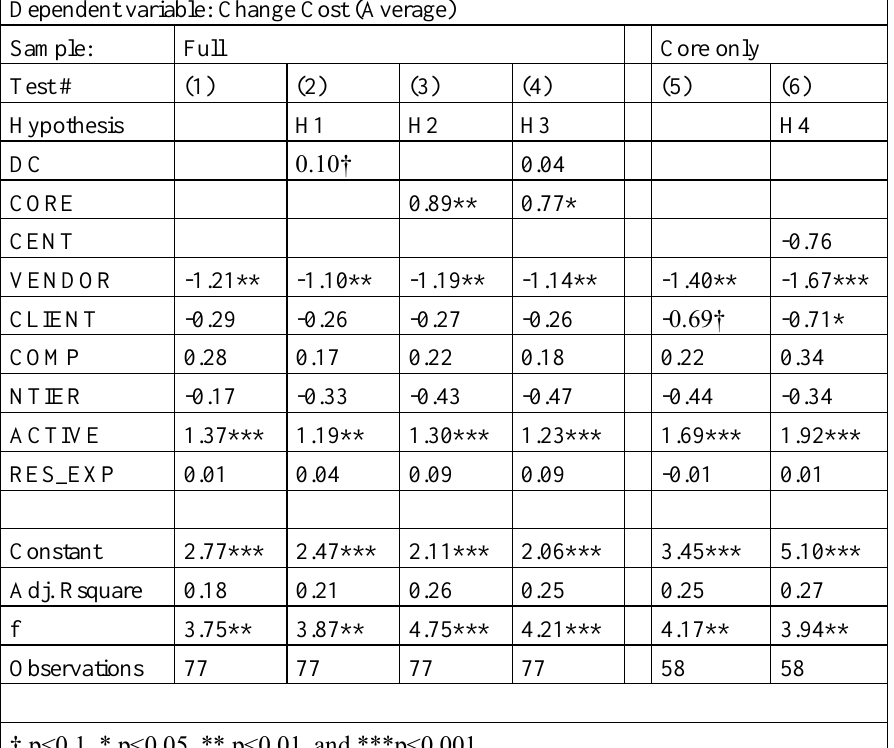
Table 3. Regression